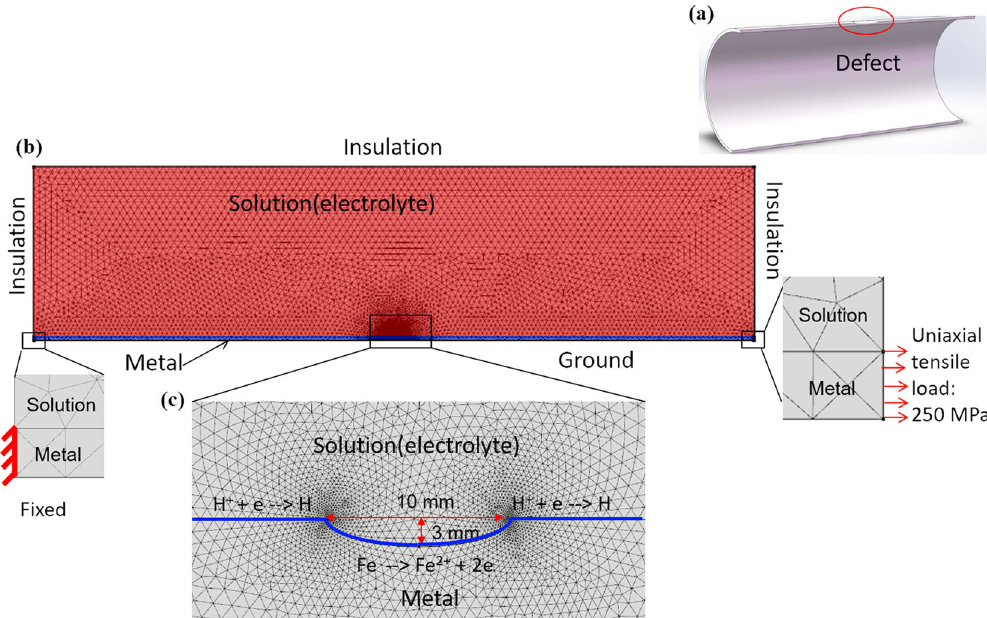
Fig. 6 Simulation model for the CISCC prediction in Type 304 SS canister. a shows a pitting defect on the surface of the canister. b Corresponding simulation model and the boundary conditions. c Enlarged image of the corroded area. Red shaded part represents the solution, and the blue shaded part represents the